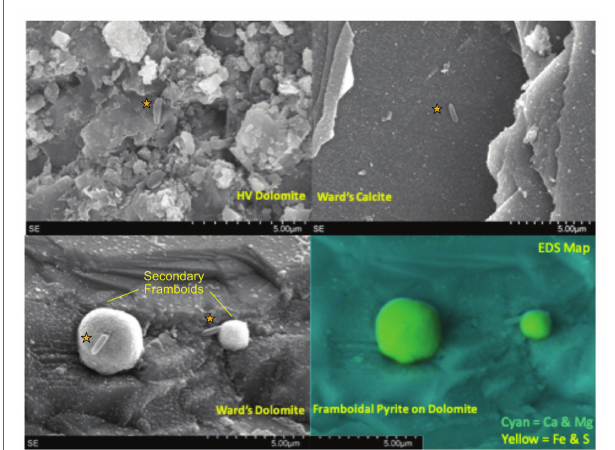
FIGURE 2 | Scanning electron micrograph (SEM) and energy dispersive x-ray spectroscopy (EDX) overlays of carbonates from Inc. 1, with microorganisms marked with orange stars. (Top Left) Natural dolomite sample (HVD) with putative cell in center. The texture of the rock presented difficulties in distinguishing cells from surroundings. (Top Right) Although calcite samples were the easiest to image, few cells and no iron sulfide framboids were visible. (Bottom Left) Cells attached to secondary framboidal structures on the dolomite standard. (Bottom right) EDX map of bottom left panel which confirms that secondary framboids are iron sulfide.